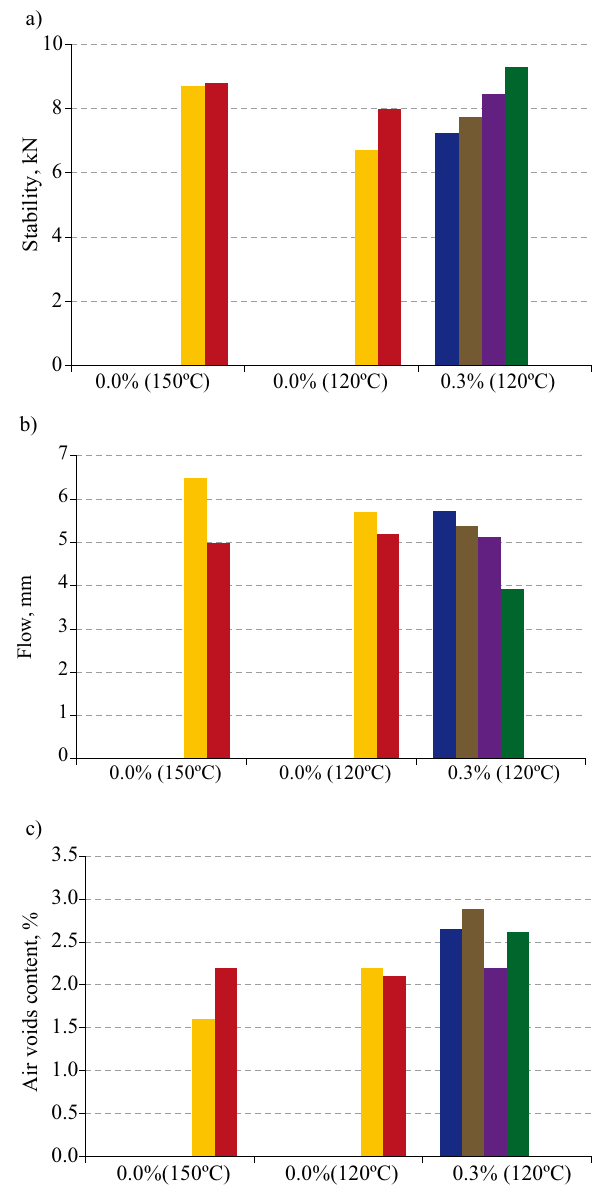
Fig. 2. Distribution of the average stability (a), flow (b) and air voids content (c) values of the asphalt mixtures AC 16 PD depending on the temperature and the type of